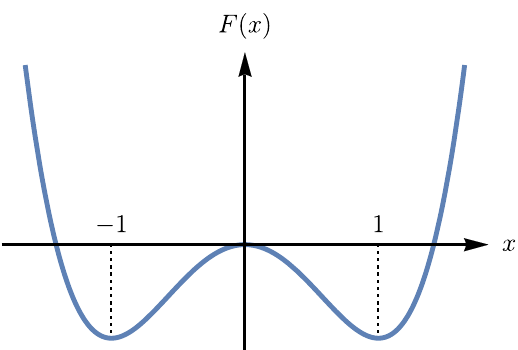
Figure 4 . The main assumption of this paper is that the function F ( x ) that determines the e(cid:11)ective potential for the eigenvalues of the meson one-point function the origin, and hence takes the form of a symmetry-breaking Ising-like potential. We rescale x so that the minima of F ( x ) are located at x =